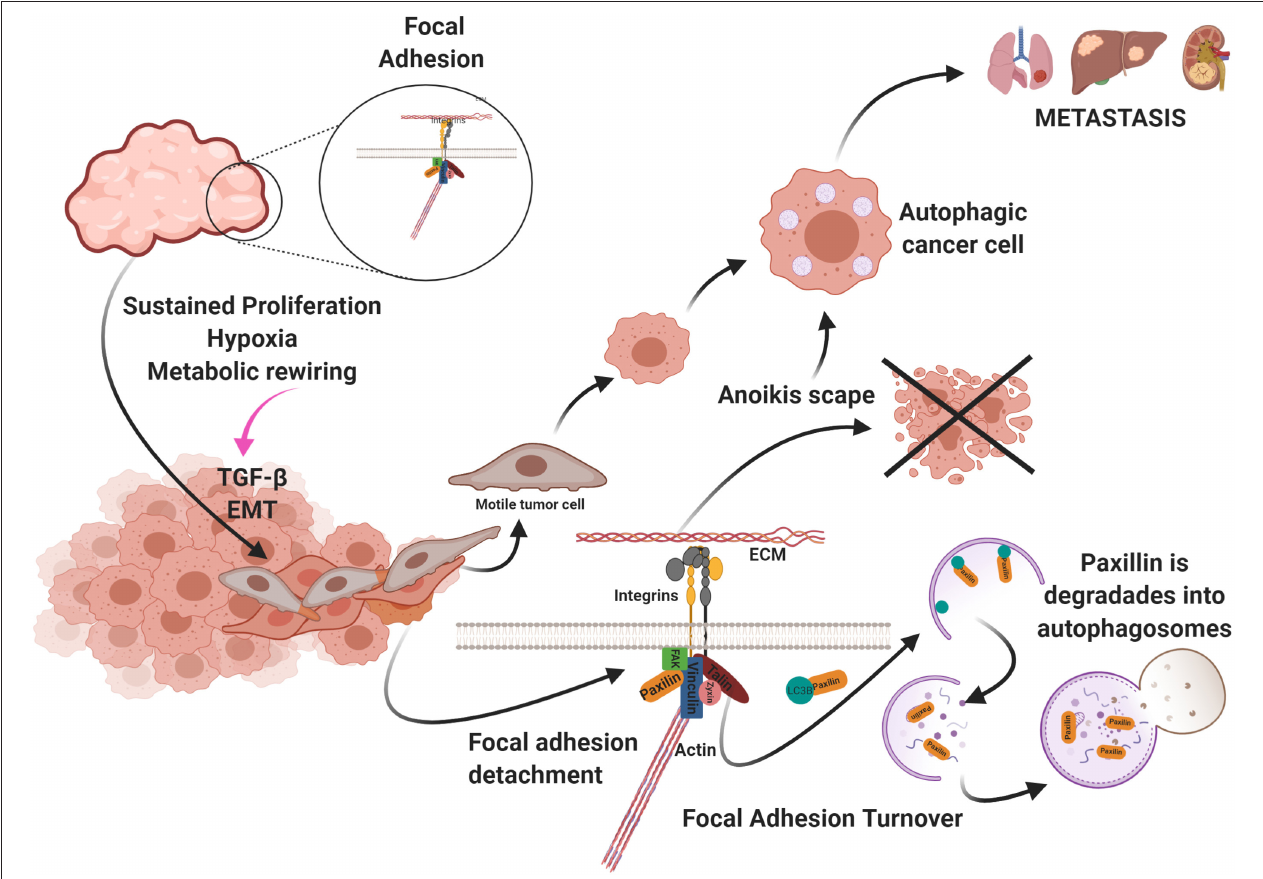
FIGURE 4 | Uncontrolled cell proliferation produces a high demand for oxygen and nutrients. As a result, the tumor becomes hypoxic and starved. These metabolic changes generate the activation of the epithelium-mesenchymal transition (EMT) program and the presence in the environment of factors that promotes metastasis and autophagy such as TGF- β . Autophagy participates in two ways favoring cellular migration: (a) avoiding anoikis and (b) in the turnover of the focal adhesion. Created by